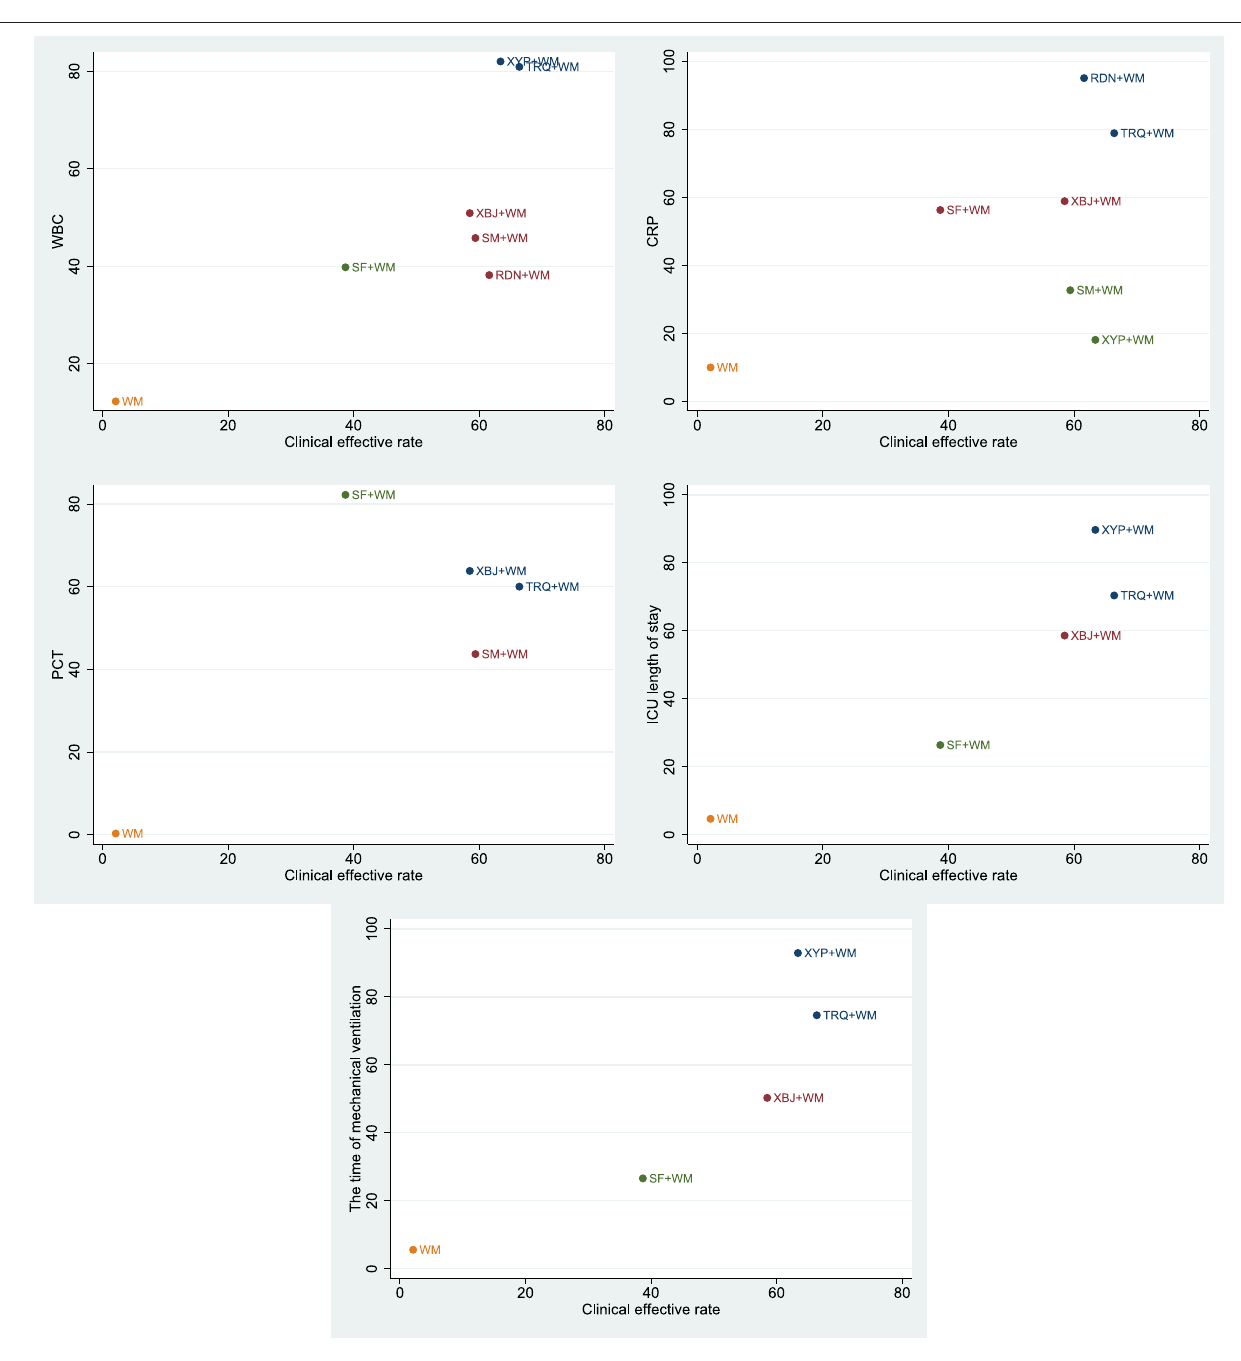
Frontiers in Pharmacology |